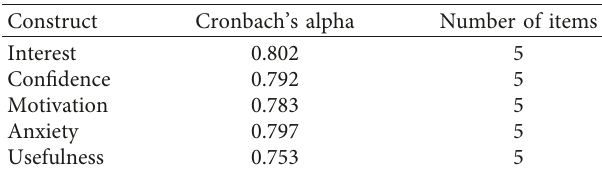
Table 4: Reliability statistics.